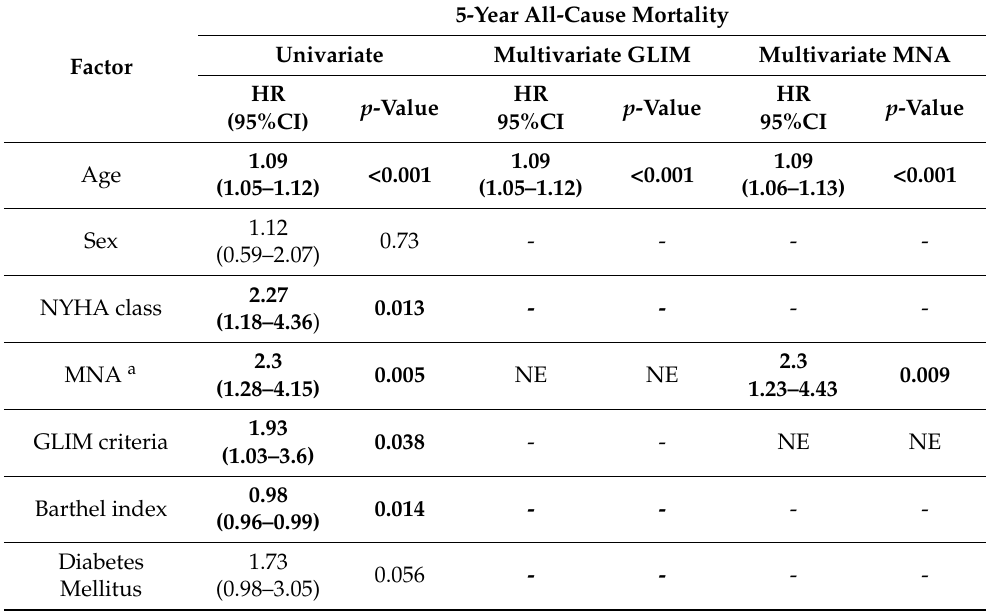
Figure 1. Prevalence of malnutrition in HF outpatients in accordance with GLIM criteria and MNA, and concordance between them. a Percentage of patients that were identified as malnourished or at nutritional risk by the 2 methods. Table 2. Cox regression analysis results for factors potentially related to the 5-year all-cause mortality in 151 subjects that attended an outpatient HF